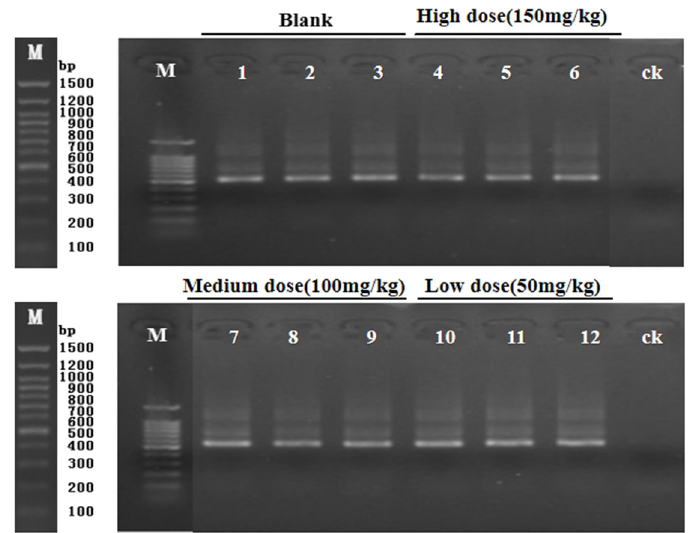
Figure 2. Electrophoresis of cecal contents of mice. PCR products 1, 2, and 3 represent K1, K2, and K3 (blank); 4, 5, 6 represent H1, H2, and H3 (high dose); 7, 8, and 9 represent M1, M2, and M3 (medium dose); 10, 11, and 12 represent L1, L2, and L3 (low dose).